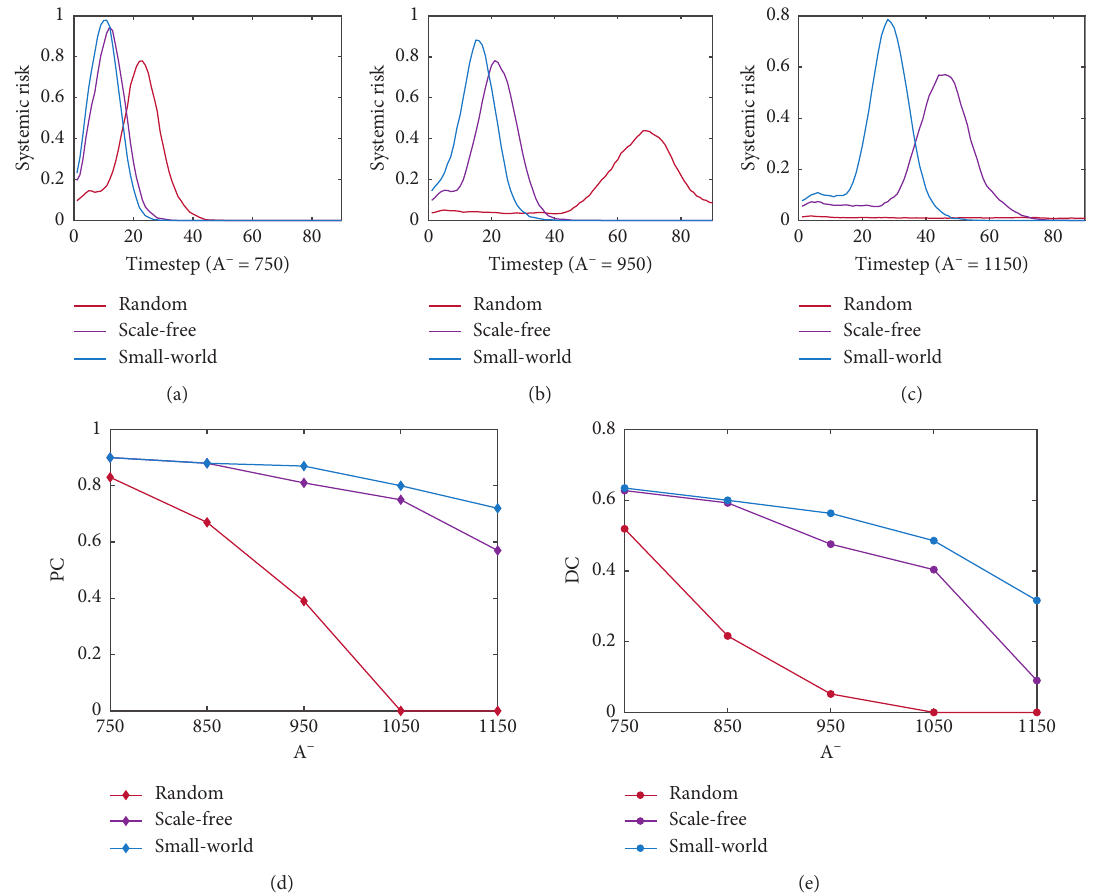
Figure 6: Evolution results of the diverse interbank networks under different A